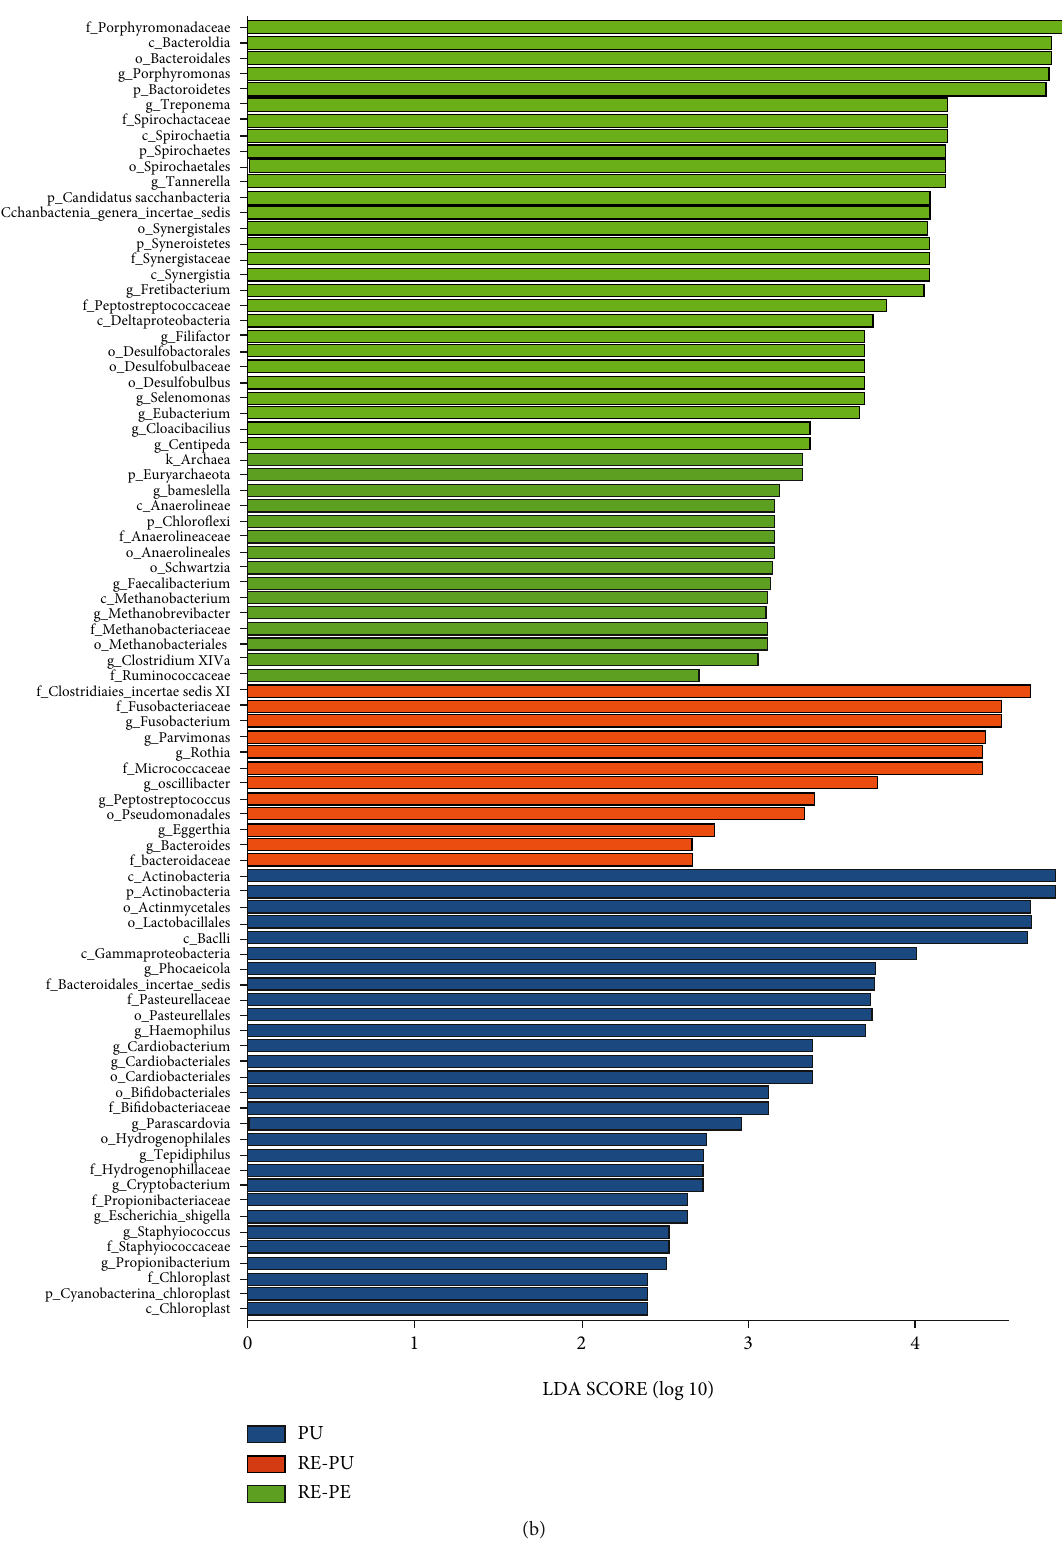
Figure 4: The linear discriminant analysis (LDA) e ff ect size (LEfSe) pro fi les of PU, RE-PU, and RE-PE. (a) Cladograms indicating the phylogenetic distribution of bacterial lineages among 3 groups. The phylum, class, order, family, and genus levels are listed in order from inside to outside of the cladogram, and the labels for levels of order, family, and genus are abbreviated by a single letter. (b) LDA along with e ff ect size measurements was applied to present the enriched bacterial genera of each